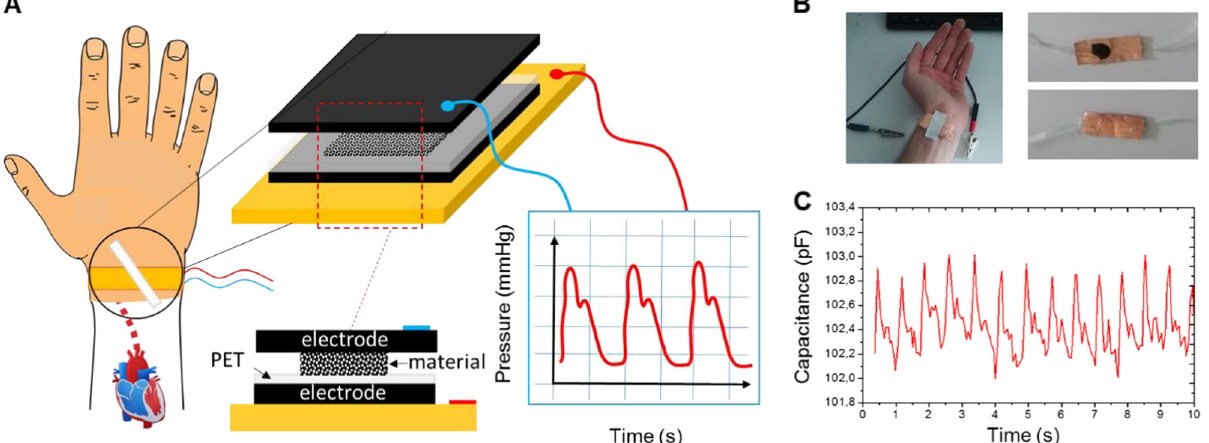
Information for voltage choice). The recorded wave signal corresponds to the typical human waveform